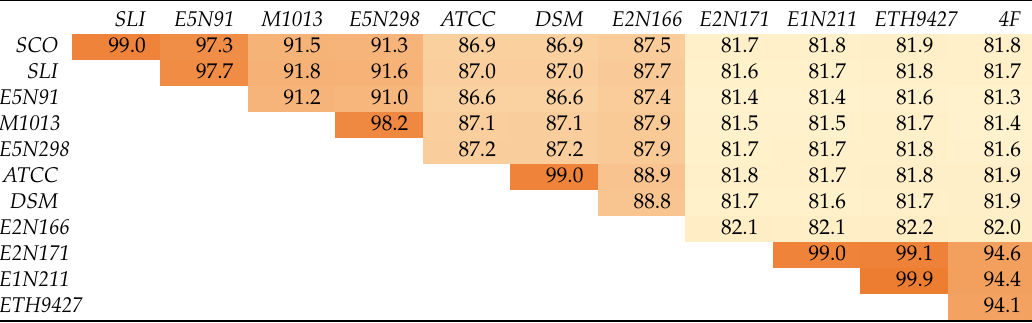
Table 2. Average nucleotide identity values of the compared strains.